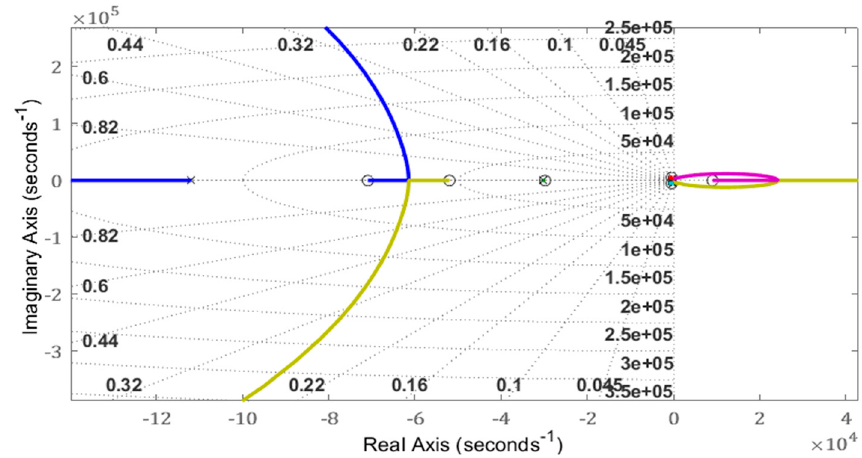
Figure 9. Zoomed version Figure 8.